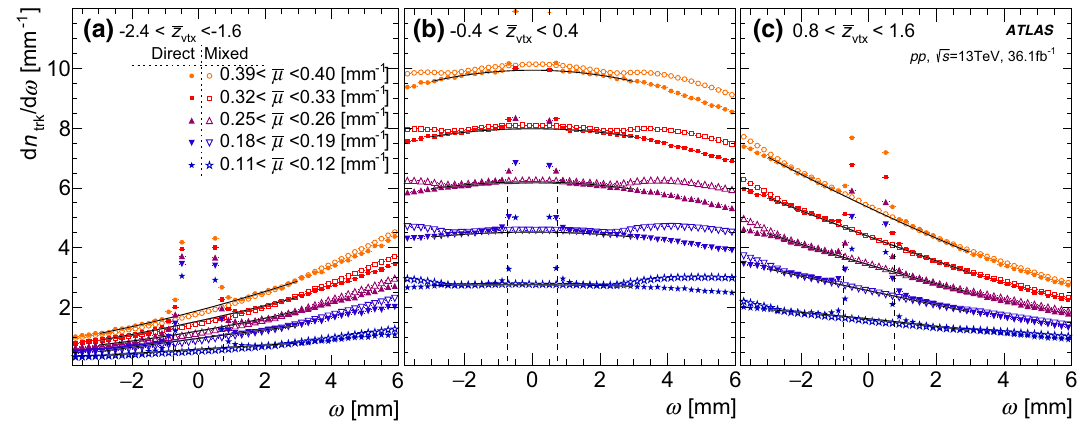
the region | ω | < 3 mm and the vertical dashed lines show the accep- tance window | ω | < 0 . 75 mm. The vertical axis is restricted to low values in order to show the Mixed events, so the peaks at ω = 0 are